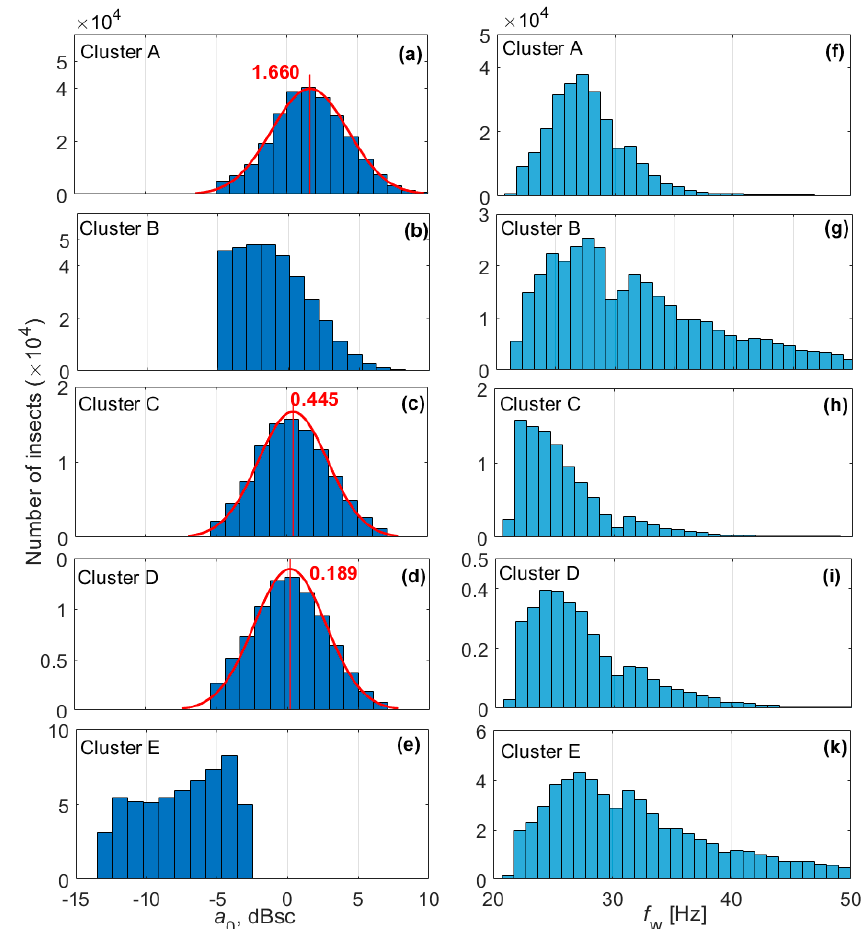
Figure 4. The distribution of size ( a 0 in dBsc, a – e ) and wingbeat frequency ( f w in Hz, f – j ) for insects from ( a , f ) cluster A (N, number of insects in the cluster: 265279), ( b , g ) cluster B (N: 33972), ( c , h ) cluster C (N: 99335) ( d , i ) cluster D (a subclass of cluster B) (N: 329871) and ( e , j ) cluster E (medium moths) (N: 574232). Red curves indicate Gaussian fits; red lines the distribution means.